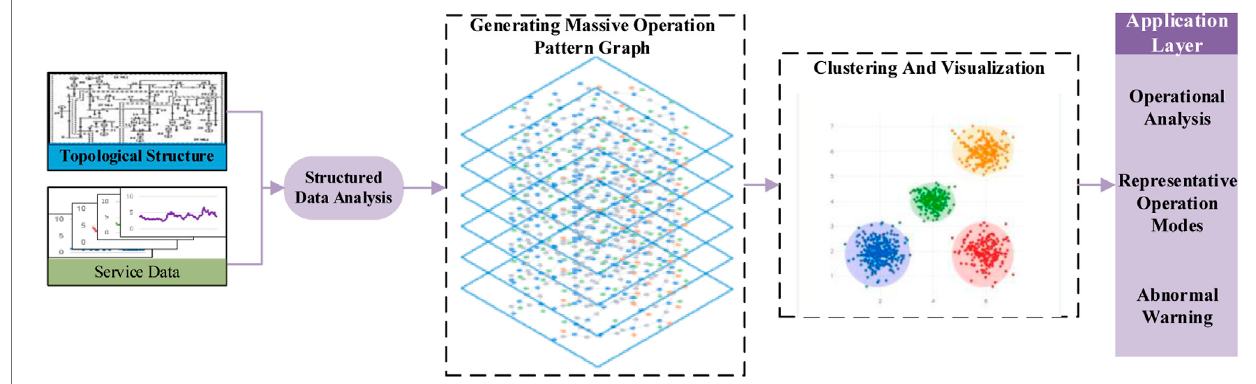
FIGURE 6 | Schematic diagram of operation mode analysis based on the knowledge graph.